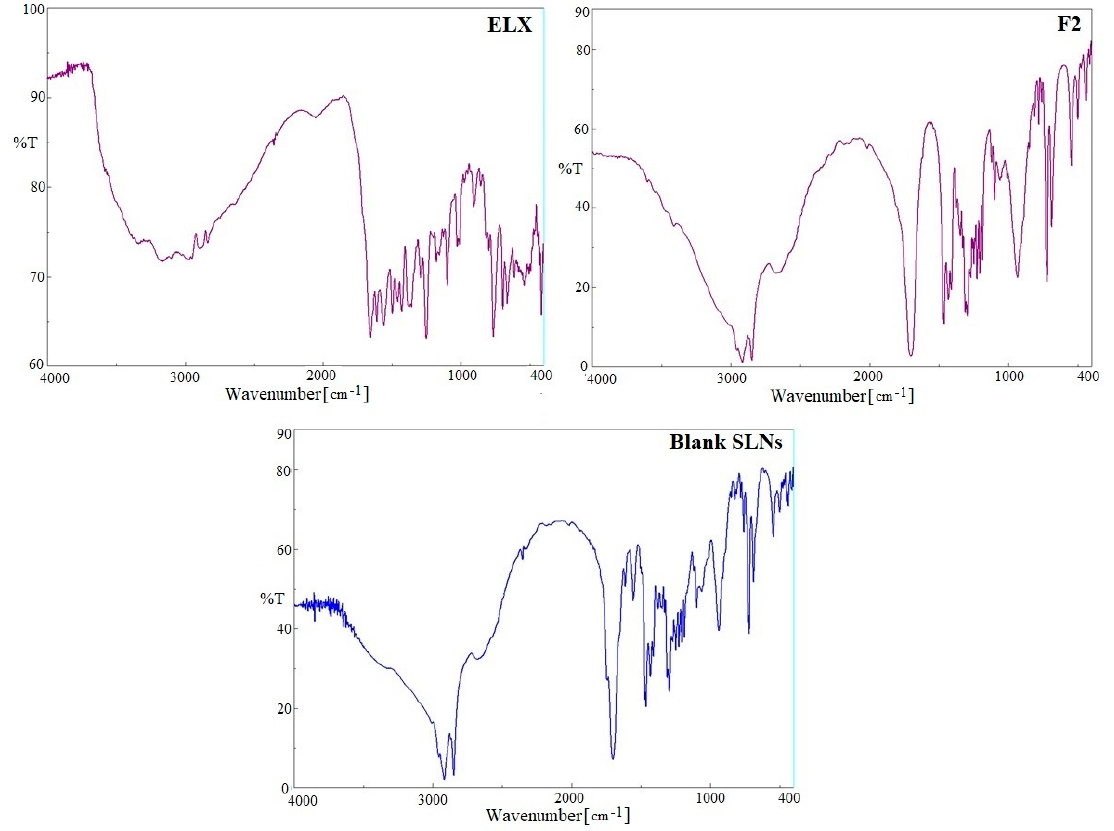
Figure 3. FTIR spectra of pure eluxadoline (ELX), blank SLNs and optimized ELX loaded SLNs (F2).